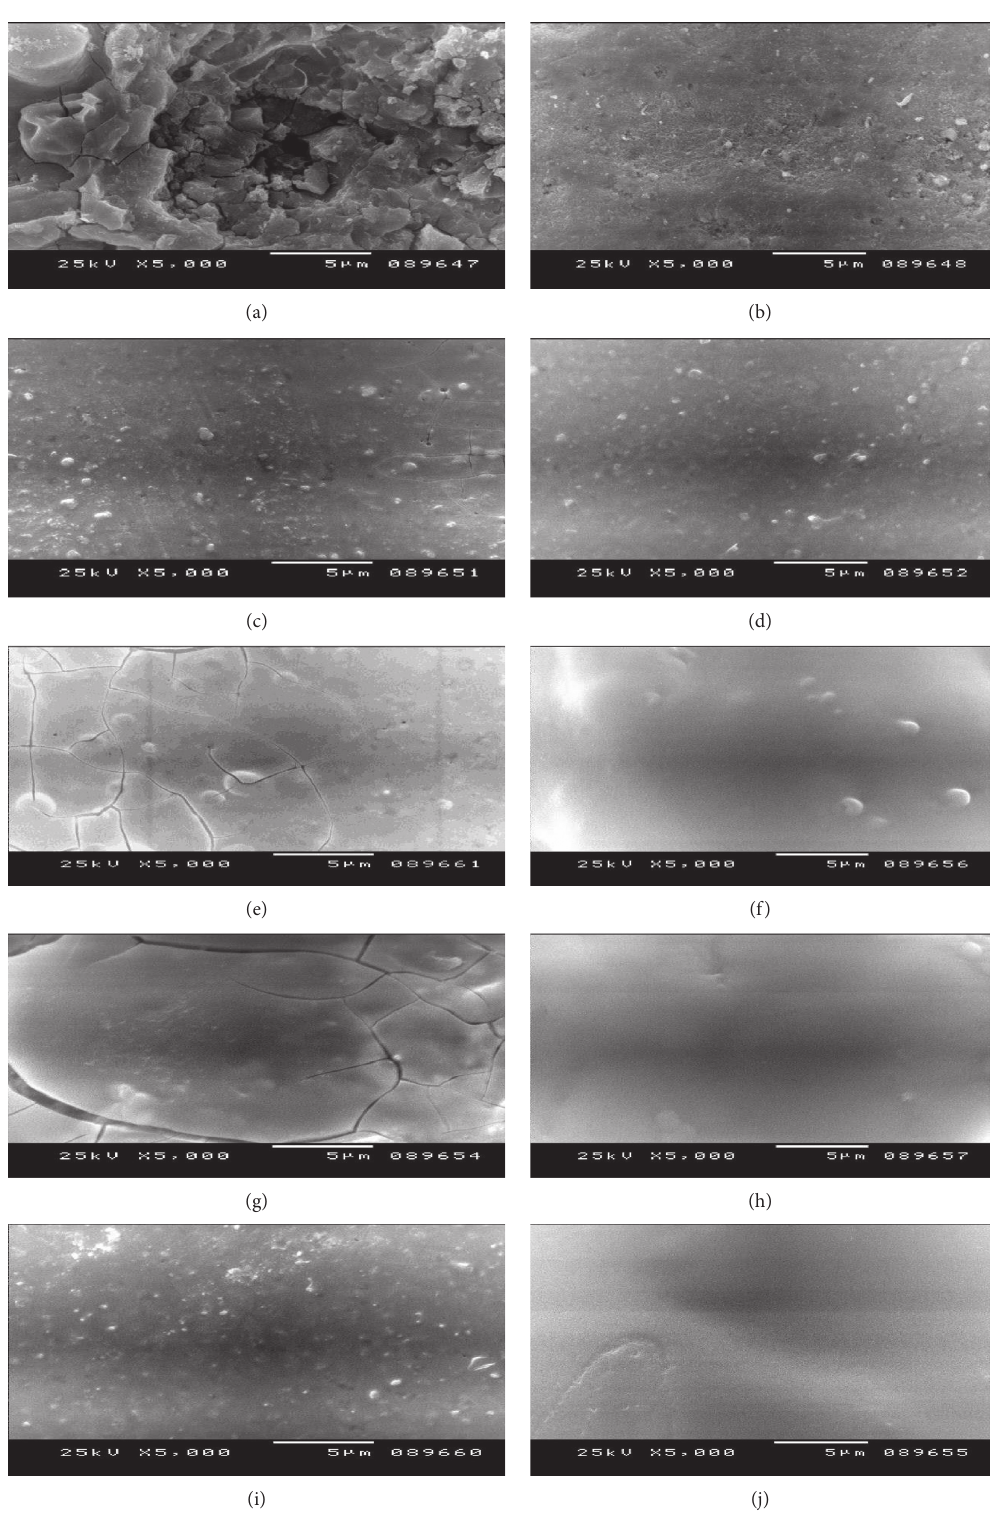
Figure 10: C-steel surface morphology before and after electropolishing at 298K in the absence and presence of natural extracts. (a) Raw C- steel sample before EP. (b) After EP without addition (blank). (c) After EP+100ppm guava leaves extract. (d) After EP+500ppm guava leaves extract. (e) After EP +100ppm chamomile extract. (f) After EP+ 500ppm chamomile extract. (g). After EP+100ppm coriander seeds extract. (h) After EP+500 ppm coriander seeds extract. (i) After EP+100ppm marjoram extract. (j) After EP +500ppm marjoram